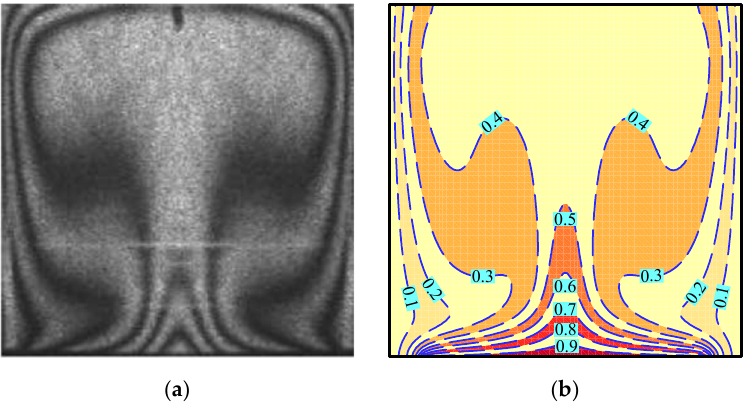
Figure 3. The motion and temperature patterns from ( a ) Gibanov et al. [26] and ( b ) current study for 𝑅𝑎 = 10 (cid:2873) , 𝐻𝑎 = 10 , 𝑀𝑛 (cid:3033) = 0.0 , 𝜙 = 0.04 , and 𝑃𝑟 = 6.2 .